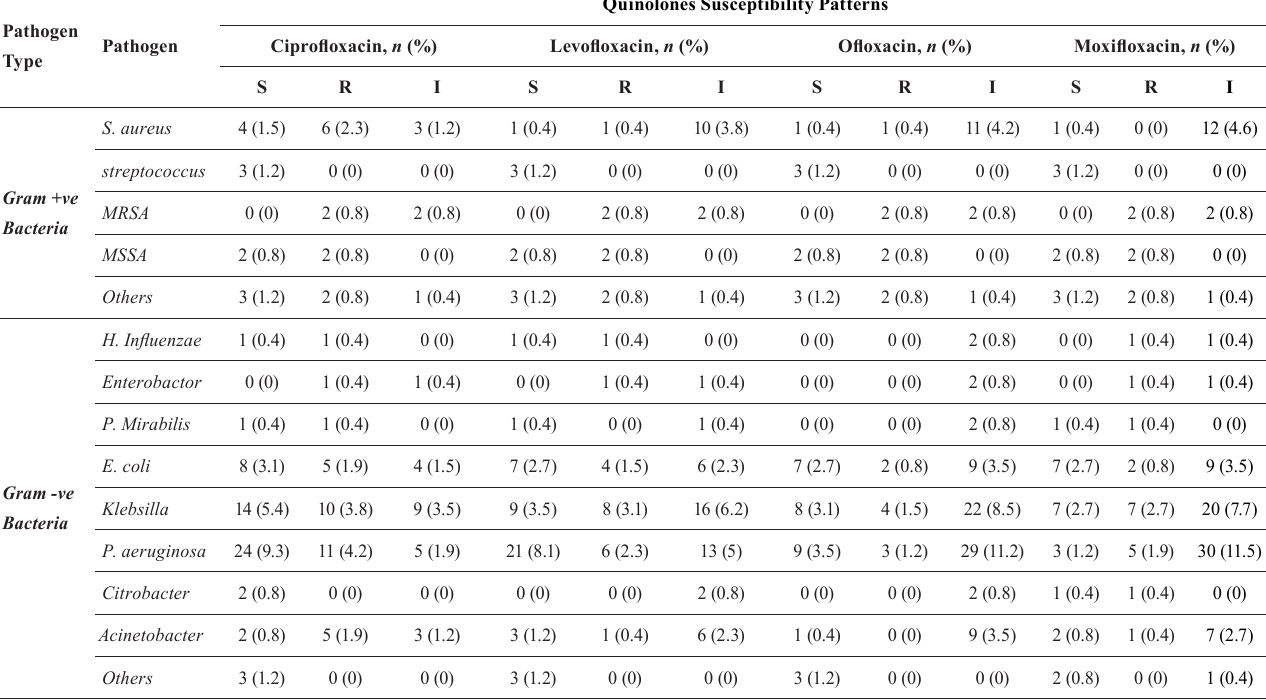
TABLE V - Q uinolones Susceptibility Patterns against Respiratory Tract